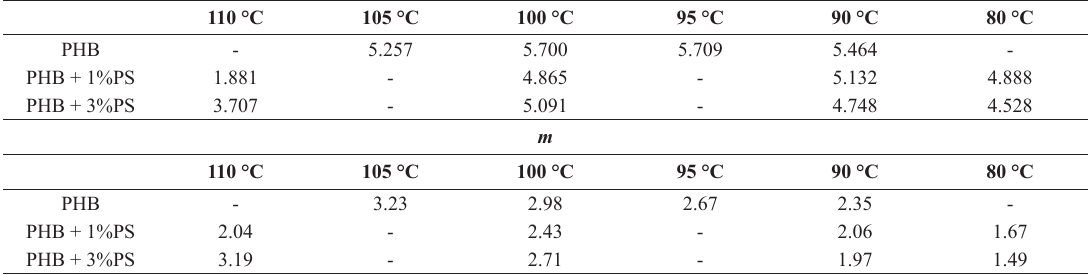
Table 1. Kinetic parameters (Ozawa model) for PHB and PHB/PS blends at different temperatures ln